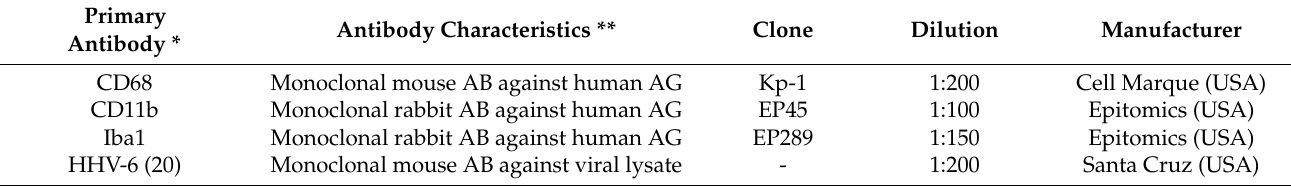
Table 2. Description and characteristics of the primary